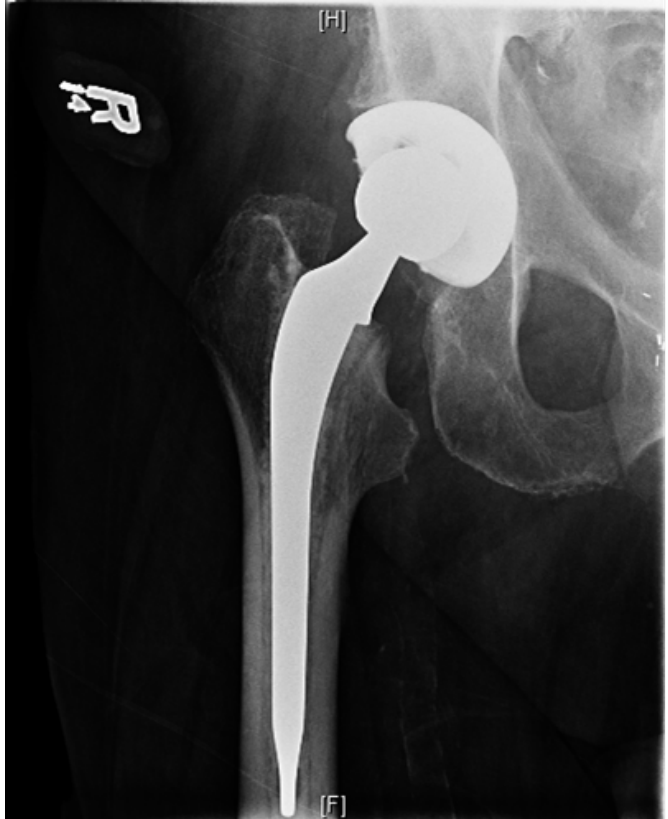
Image 3. Post reduction anterior-posterior radiograph of the